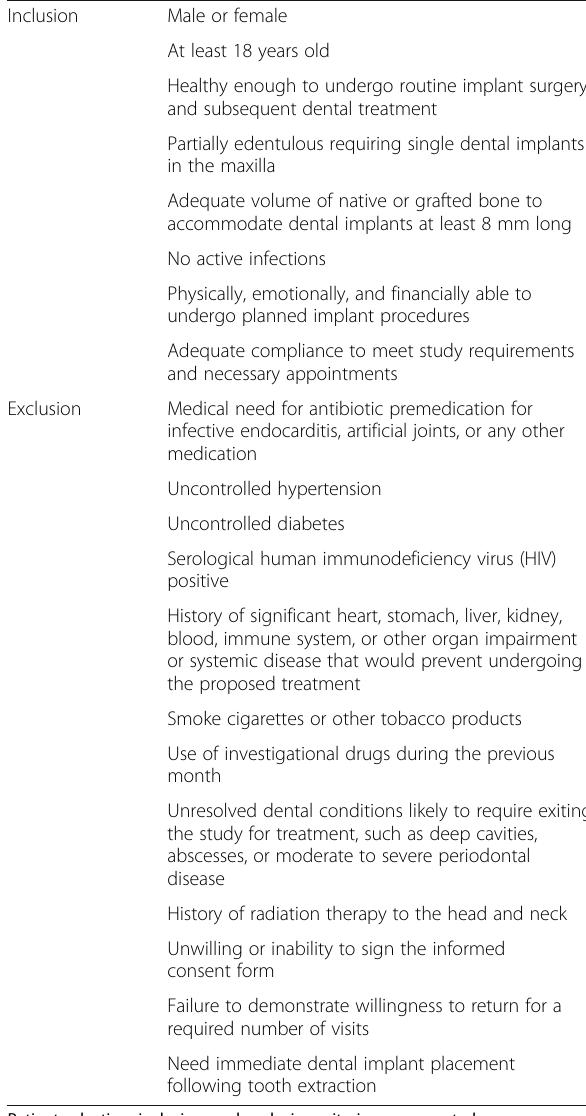
Table 1 Patient selection